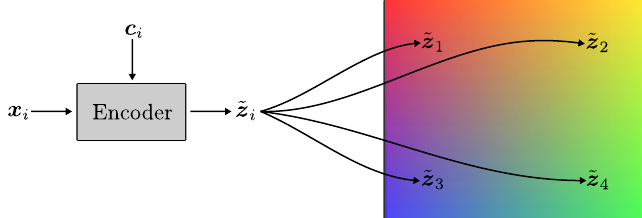
= c ( E ) mapping the input data x i i